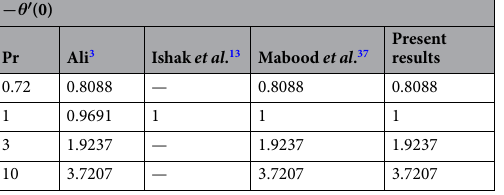
Table 4. Comparison of θ − ′ (0) for different values of Pr with β → ∞ , Bi → ∞ and